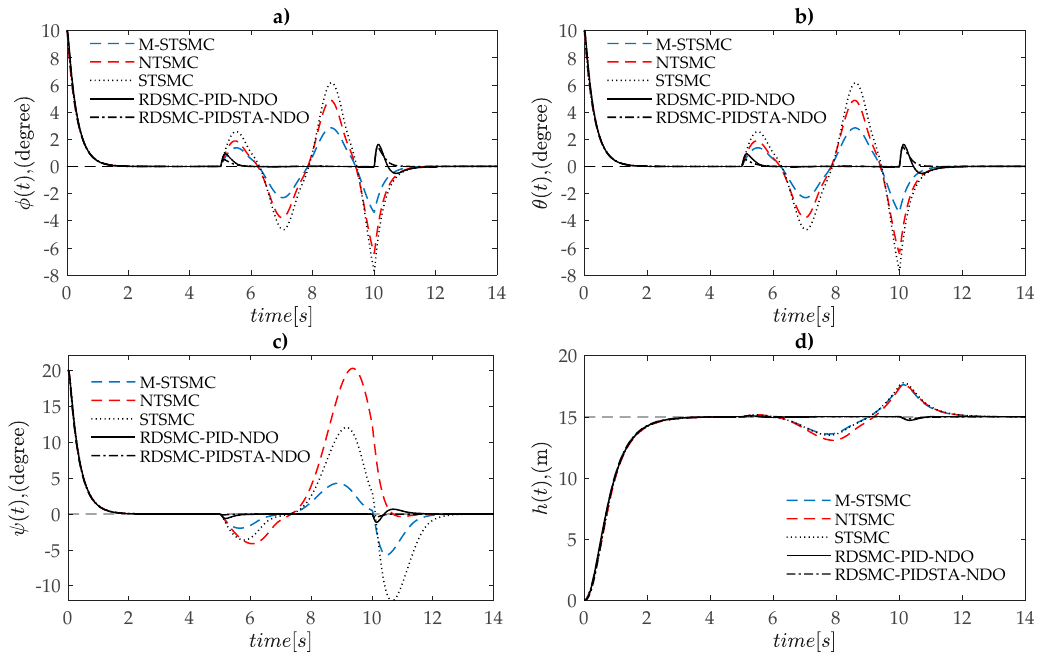
Figure 5. Comparison of attitude and altitude performance between the proposed RDSMC-NDO method and other approaches: ( a ) roll control performance; ( b ) pitch control performance; ( c ) yaw control performance; and ( d ) altitude control performance.